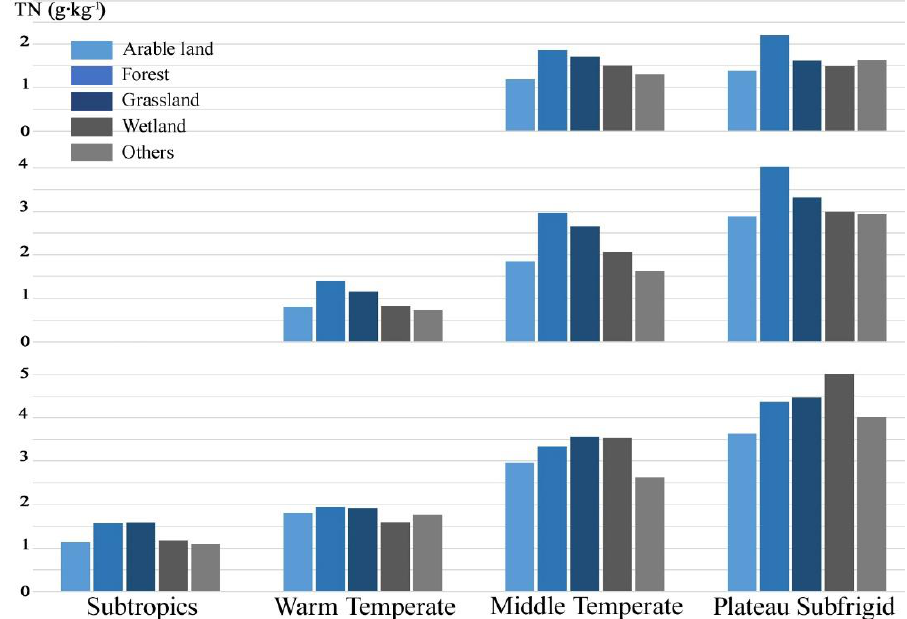
Figure 9. The average TN content under different land use types in the climate zones of China. The “others” group contains construction land and other unused land.